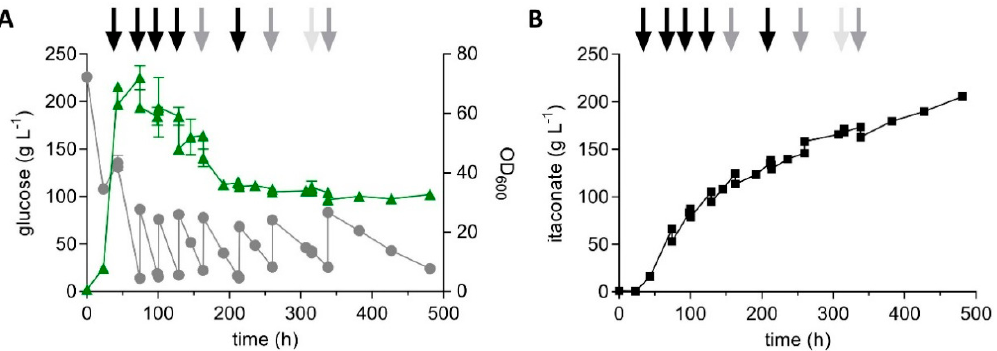
Figure 5. High-density pulsed fed-batch fermentation of U. maydis strain K14. (A) concentration of glucose ( • ) and OD 600 values ( ▲ ) and (B) concentration of itaconate ( ■ ) during fermentation in a bioreactor containing batch medium (200 g L − 1 glucose, 4 g L − 1 NH 4 Cl, CaCO 3 as buffering agent, 30 °C, 1000 rpm, top pitched blade impeller, bottom Rushton impeller). Arrows indicate the addition of 80 g glucose + 50 g CaCO 3 (black arrow), 80 g glucose (grey arrow), or 50 g CaCO 3 (light grey arrow). Error bars indicate the deviation from the mean ( n = 2).